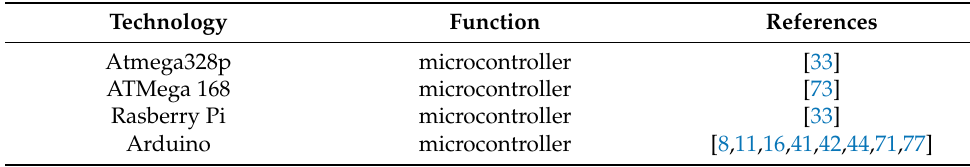
Table 2. Used microprocessor platforms.